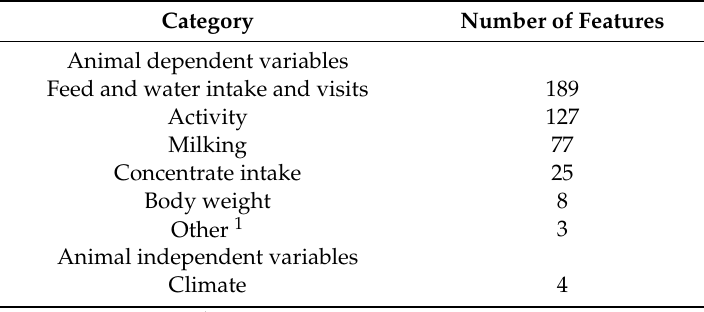
Table 2. Number of features by category, before feature